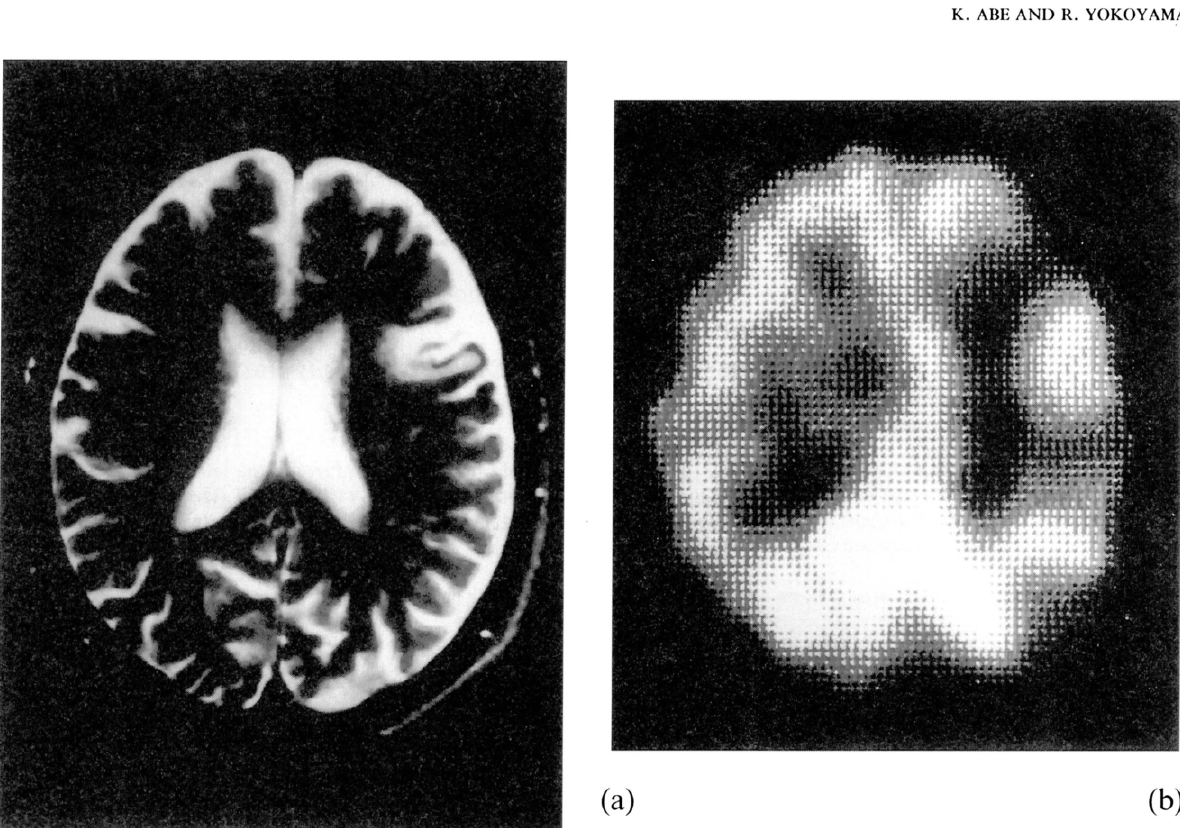
FIG. 1. (a) A T2-weighted magnetic resonance image. Imaging was carried out in a 0.5 Tesla superconducting system with spin-echo method, TR/ TE = 2500/ 90 ms. A T2 high intensity lesion is seen in the left middle frontal gyrus and adjacent white matter. (b) A single photon emission tomographic image using 123I-iodoamphetamine. Reduced isotope uptake is demonstrated in the left middle frontal gyrus and adjacent white matter.